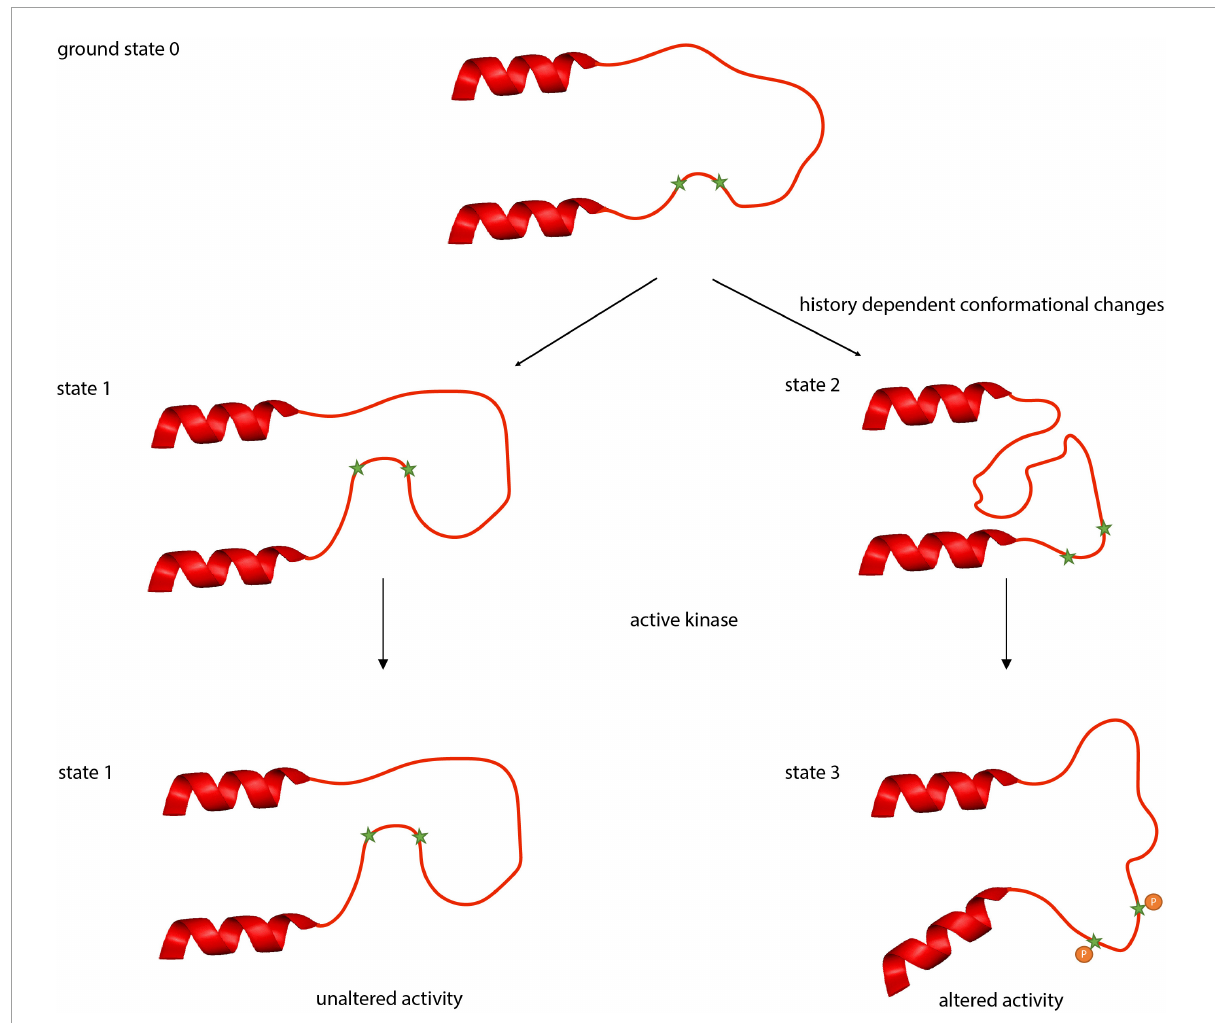
FIGURE5 Putative conformational states of the intrinsically disordered regions between α 8 and α 9 helices in KCC2. Intrinsically disordered regions can adopt a variety of conformational states. Beginning with the ground state 0, different physiological conditions (activity, pH, temperature) can induce different conformational states (states 1 or 2). These conformational changes can result in occlusion (state 1) or deocclusion (state 2) of phospho-sites to signaling pathways. Phosphorylation in the deoccluded state results subsequently in altered transport